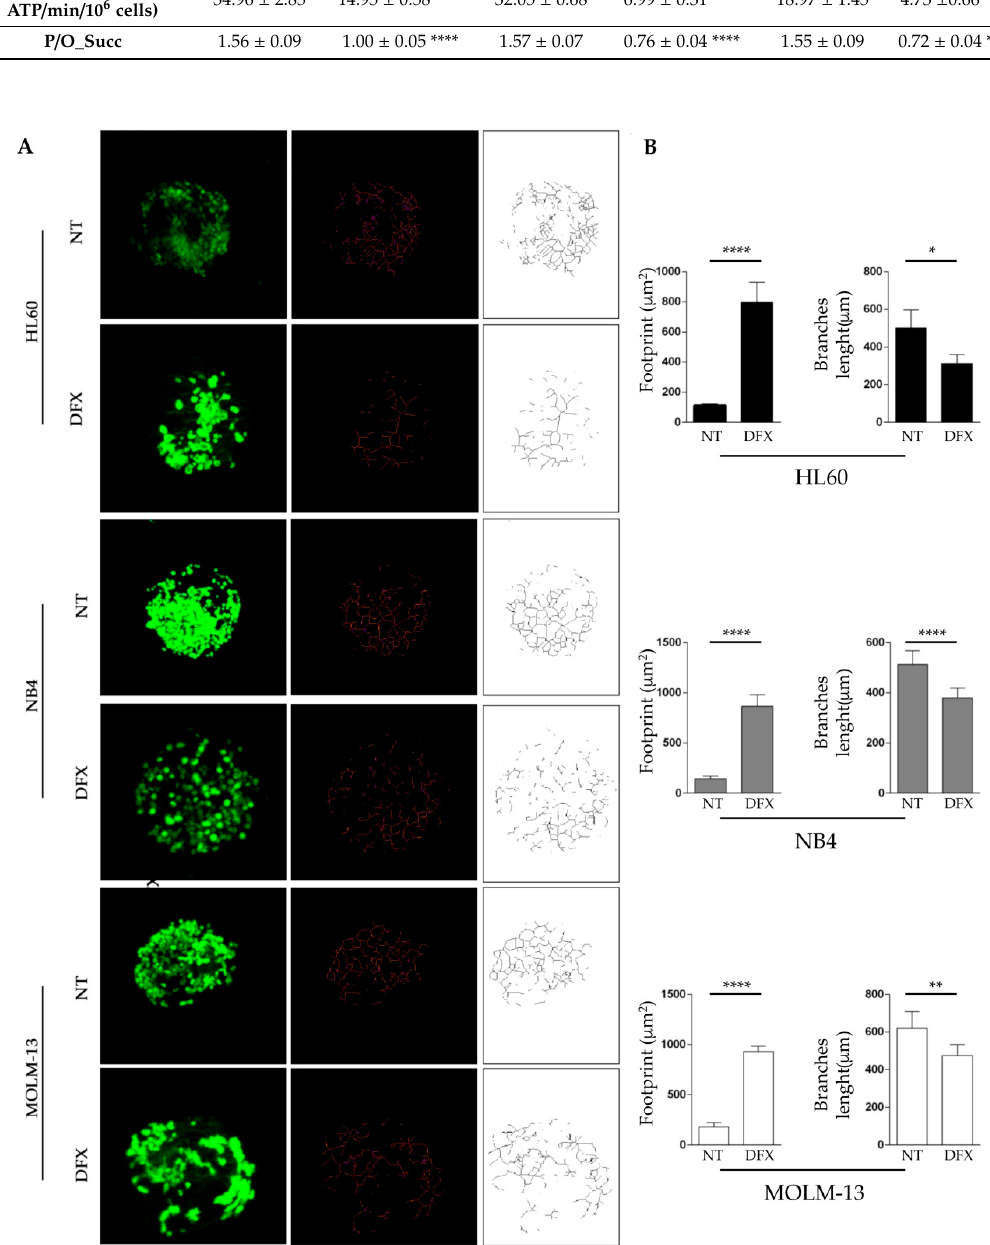
Figure 1. Iron chelation induces an altered network in acute myeloid leukemia cell lines. HL60, NB4, and MOLM-13 were treated for 48 h with 50 µ M of DFX and subsequently incubated with 100 nM of MitoTracker green for mitochondrial network analysis. ( A ) The original green image obtained with confocal microscope is a three-dimensional (3D) image created with z-stack project (63 × magnification). It has been processed using the MiNA toolset to generate an accurate skeleton. In red and black and white, the skeleton of mitochondria of the three cell lines treated with DFX is visible, compared to respective control. ( B ) Quantification of mitochondria footprint and branches length, which corresponds respectively to the area and connection, of mitochondria expressed in µ m. Abbreviations: NT, not treated; DFX, Deferasirox. * p ≤ 0.05, ** p ≤ 0.01, and **** p ≤